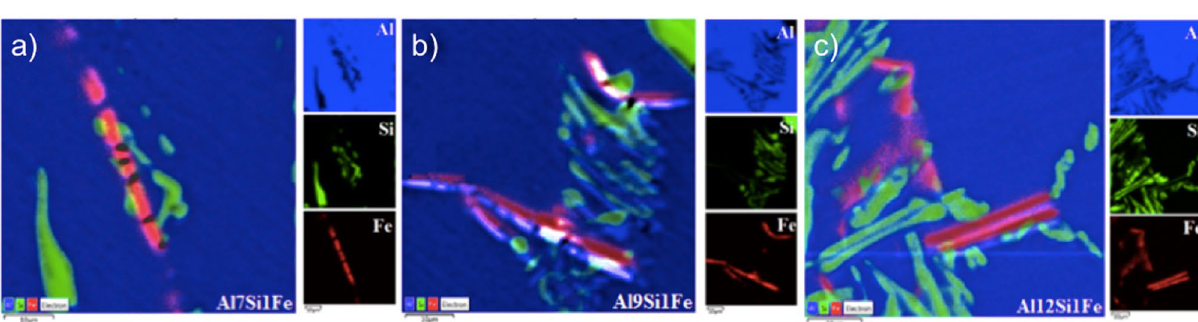
Figure 7. SEM–EDS maps highlighting typical eutectic precipitates present in the alloys containing 7 ( a ), 9 ( b ) and 12 wt% Si ( c ) and 1 wt% Fe, without Nb addition. Al, Si and Fe are highlighted in blue, green and red,